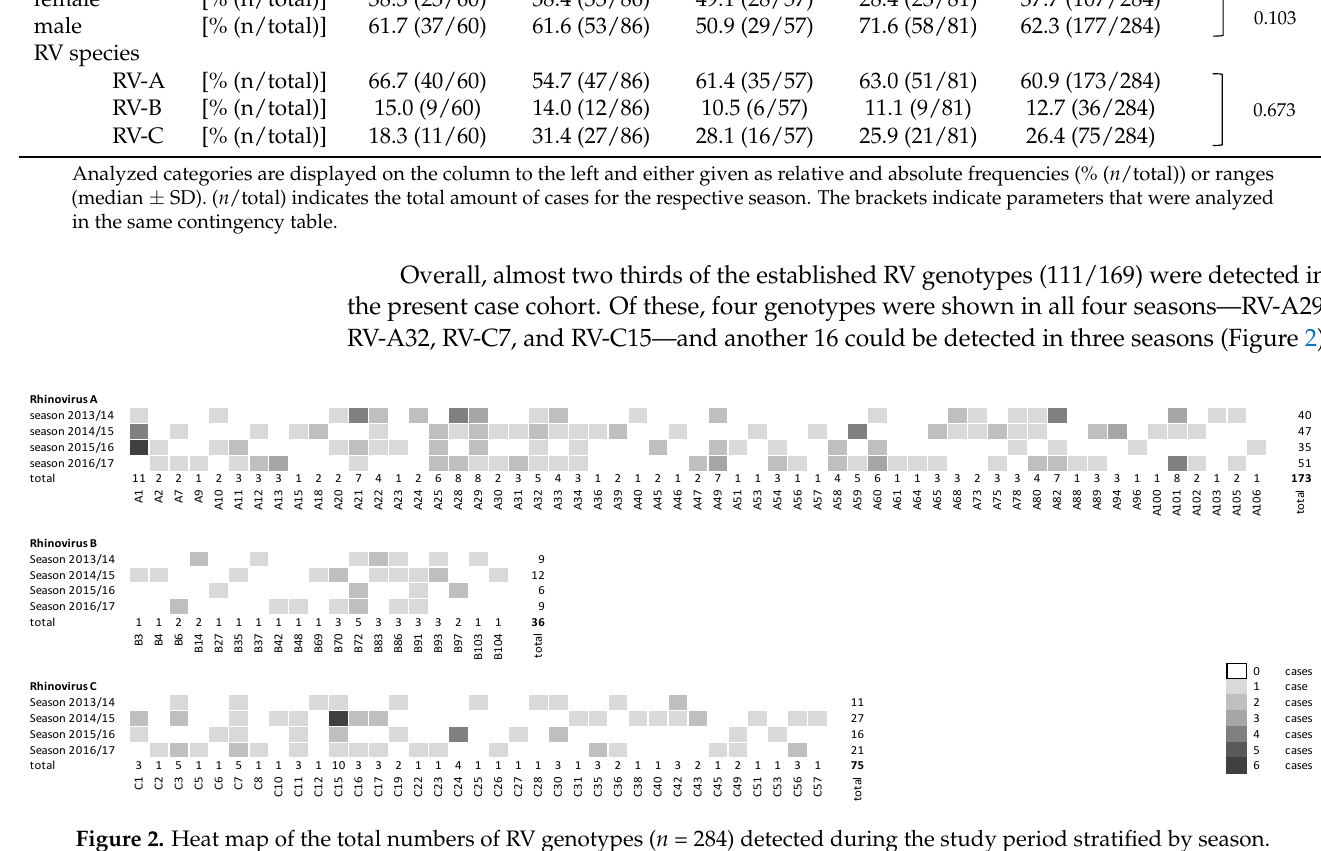
between RV species ( p = 0.193) or between seasons ( p = 0.957). The gender was female for 37.7% and male for 62.3% of all patients. Again, no difference was noted between seasons ( p = 0.103) or between RV species ( p = 0.548) (Table